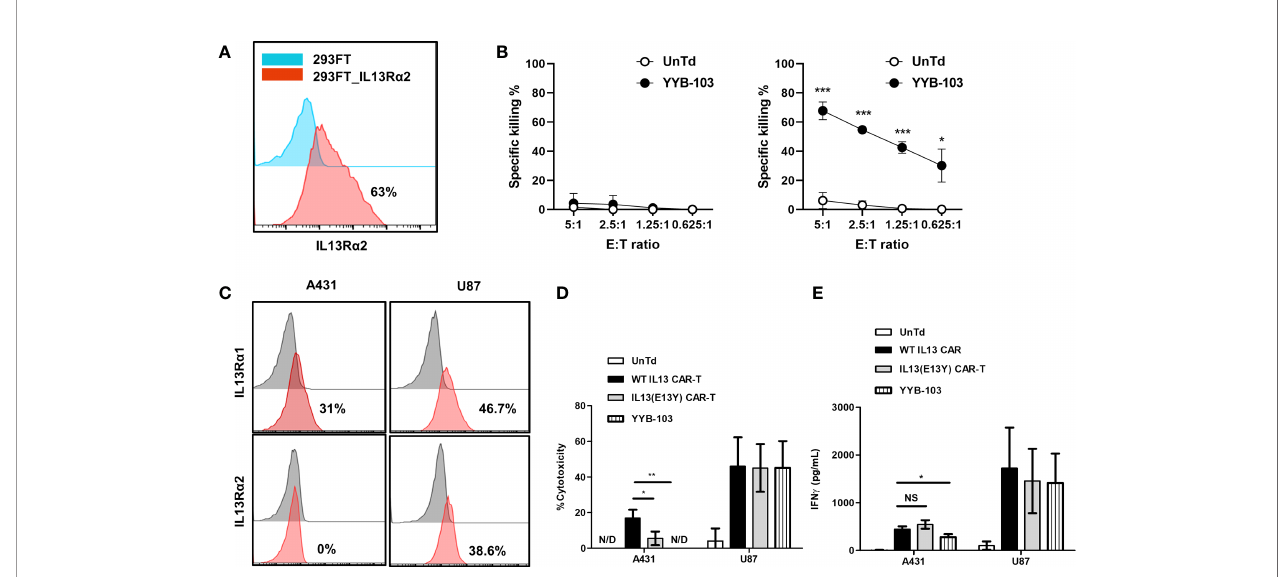
FIGURE 2 | Modi fi ed IL13 in YYB-103 CAR T cells preferentially binds to IL13R a 2 and not IL13R a 1 on tumor cells. (A) Flow cytometry con fi rmation of IL13R a 2 expression in naïve (blue) and IL13R a 2-transfected (red) 293FT cells. (B) In vitro cytotoxicity assay was performed by co-culturing CAR T cells with naive (left) and IL13R a 2-transfected (right) 293FT cells for 18 h. (C) Flow cytometry evaluation of IL13R a 1/IL13R a 2 expression revealed IL13R a 1 + /IL13R a 2 − for A431 cells and IL13R a 1 + /IL13R a 2 + for U87 cells. (D) In vitro cytotoxicity assay was performed by co-culturing different IL13 muteins CAR T cells with A431 (IL13R a 1 + /IL13R a 2 − ) or U87 (IL13R a 1 + /IL13R a 2 + ) cells for 18 h. (E) IFN- g production of CAR T cells was measured in culture supernatant after co-culture with A431 or U87 cells. Statistical signi fi cance was determined by using the unpaired two-tailed Student ’ s t-test for comparisons between two samples. * p < 0.05, ** p < 0.01, *** p < 0.005). E:T ratio, effector-to-target cell ratio; CAR, chimeric antigen receptor. NS, not signi fi cant; N/D, not